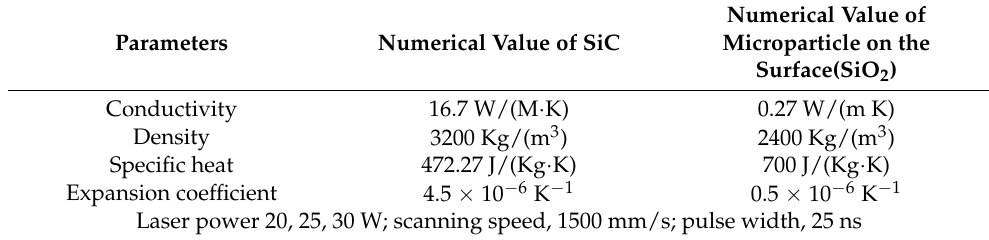
Table 2. Numerical simulation parameters of laser